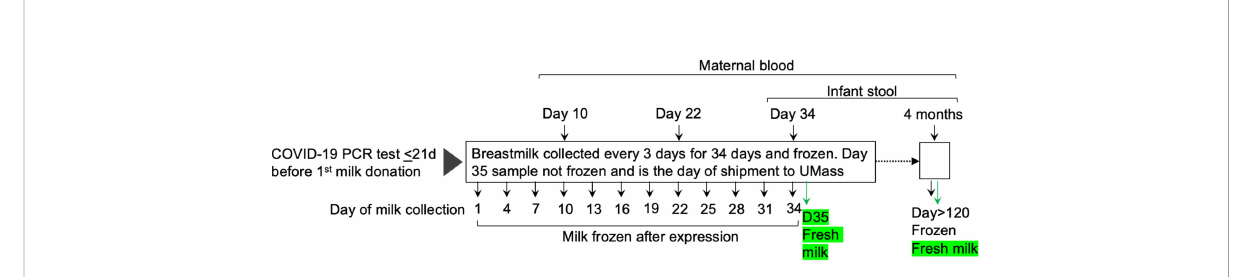
FIGURE 1 Overview of collection of milk, dried blood spot cards, and infant stool samples. Thirty lactating participants who had a positive PCR-test and their fi rst COVID-19 symptoms within the previous 21 days were enrolled between December 2020 and March 2021. Participants were asked to provide serial bilateral milk samples at 12 timepoints (~ every 3 days) over 35 days. A second set of samples was collected at least four months after the fi rst sample from the fi rst set. Participants also were asked to provide their blood spotted onto cards and samples of their infants ’ stool at the indicated timepoints. Fresh, never previously frozen, milk samples (indicated in green) were obtained at the two indicated